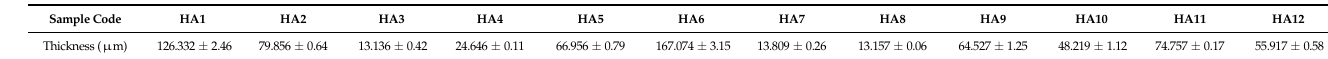
Figure 4. SEM images recorded on samples HA9 ( a ) and HA12 ( b ) obtained at 90 ◦ C. Thickness measurements were performed for each sample in three different areas and the results are presented in Table 3 as mean values with standard deviation. Some of the recorded micrographs are presented in Figure S1 from the Supplementary Materials. Table 3. HA layer